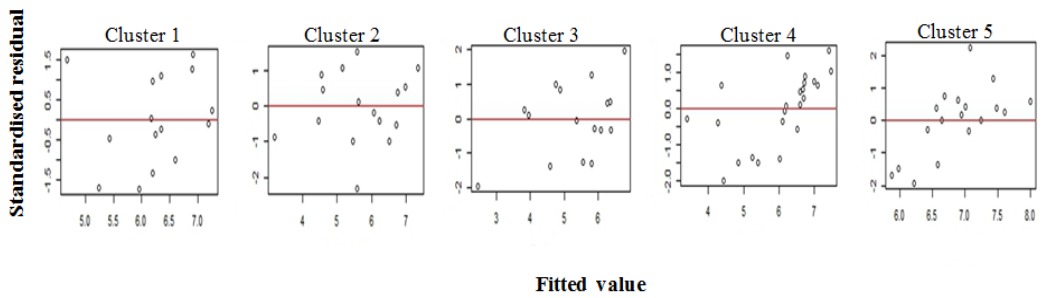
Figure 9. Standardized residuals vs fitted value plots for all clusters in case of 5% AEP flood.